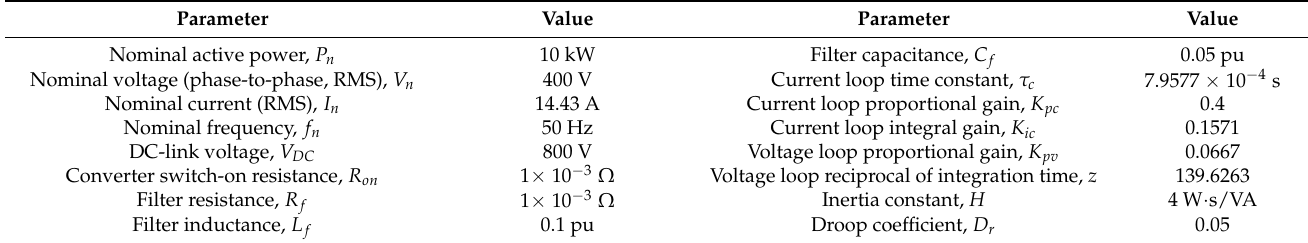
Table A2. Parameters of the wind turbine (WT) GSC.